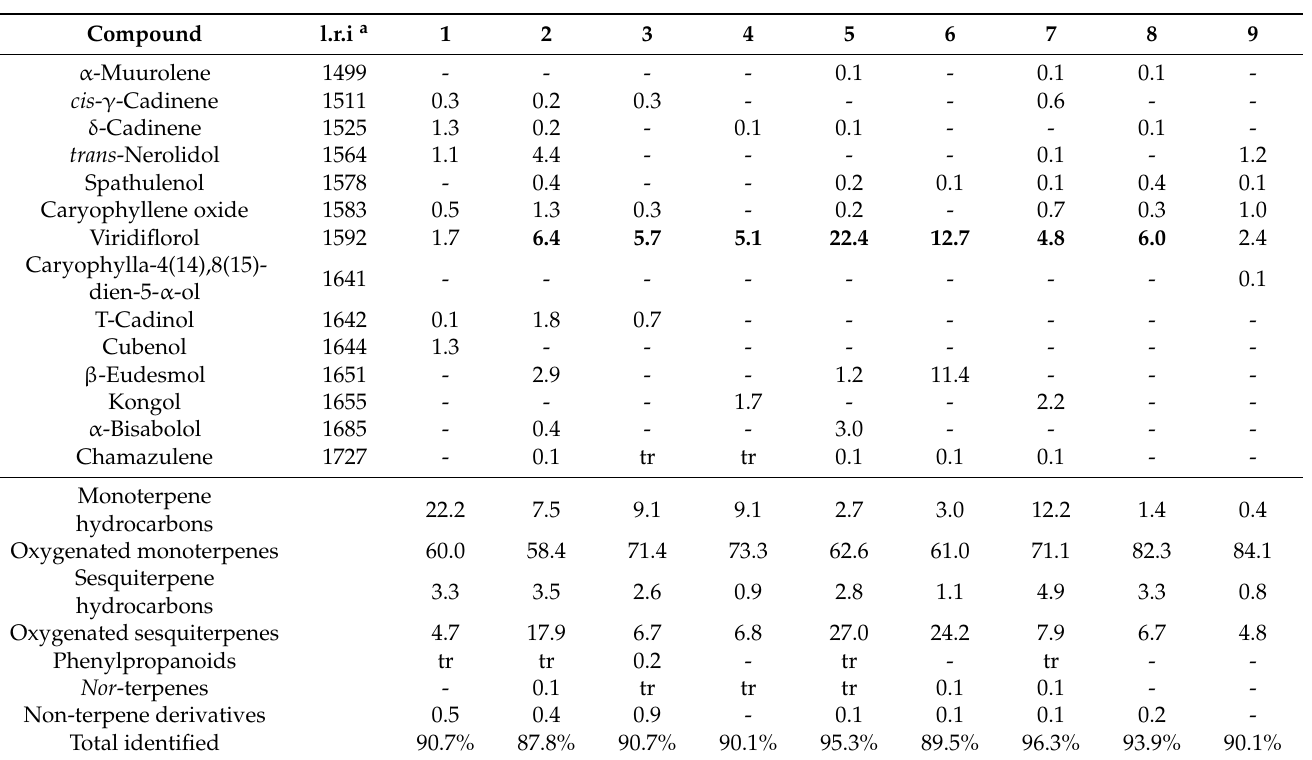
Figure 1. Map of samples (1–9) distributions.